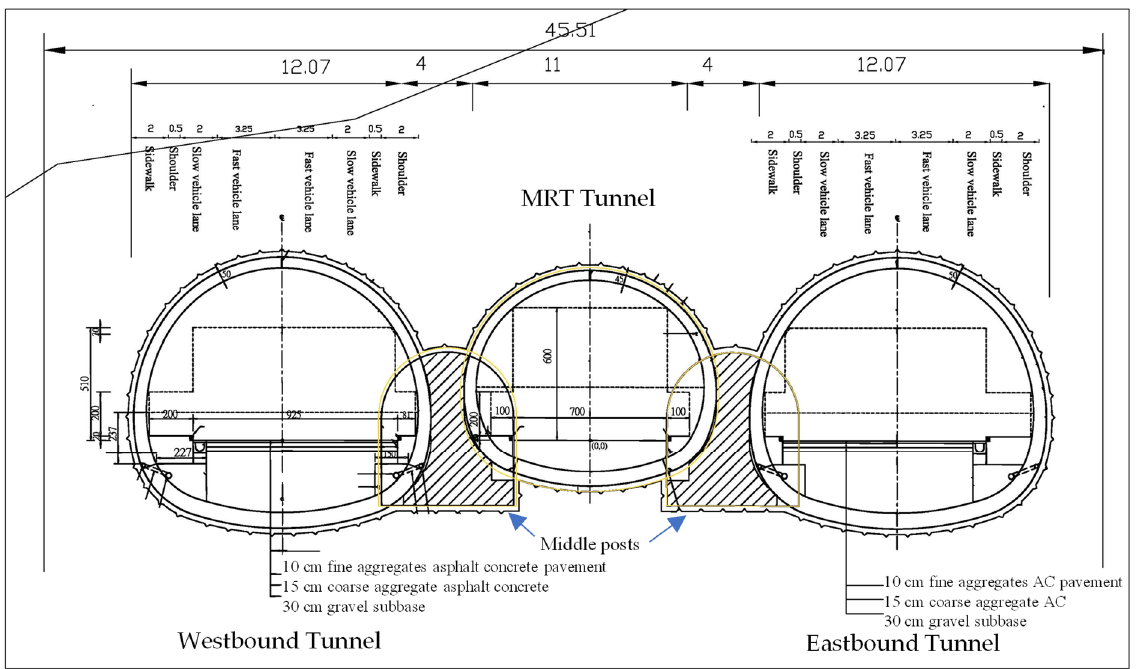
Figure 1. Standard cross section of Ankeng Tunnel.